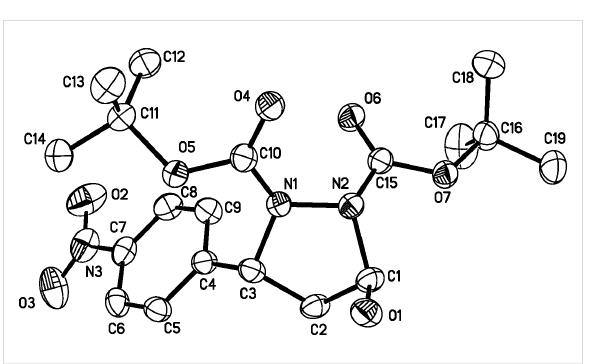
Figure 2: X-ray crystal structure of racemic 4a (25% thermal ellip-